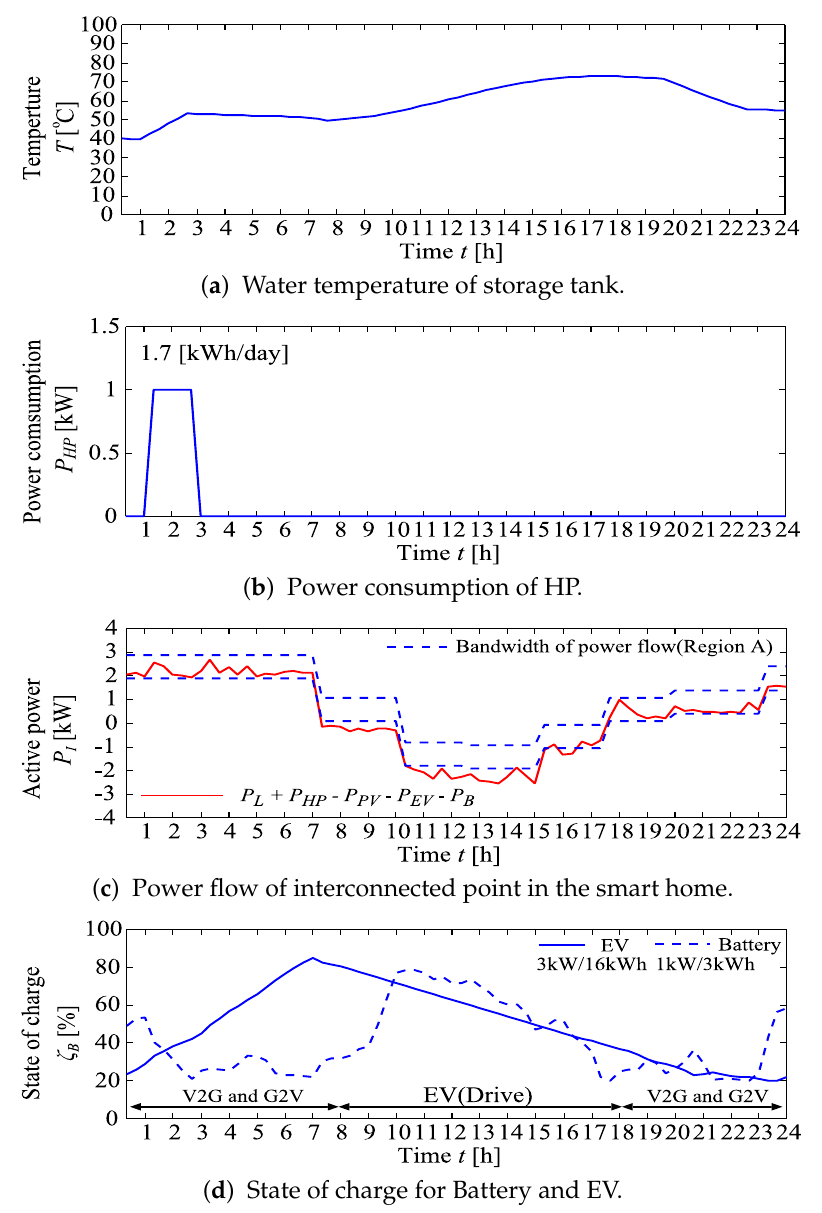
Figure 8. Simulation results without considering re-forecast, re-plan and uncertainties on a fair day (Case